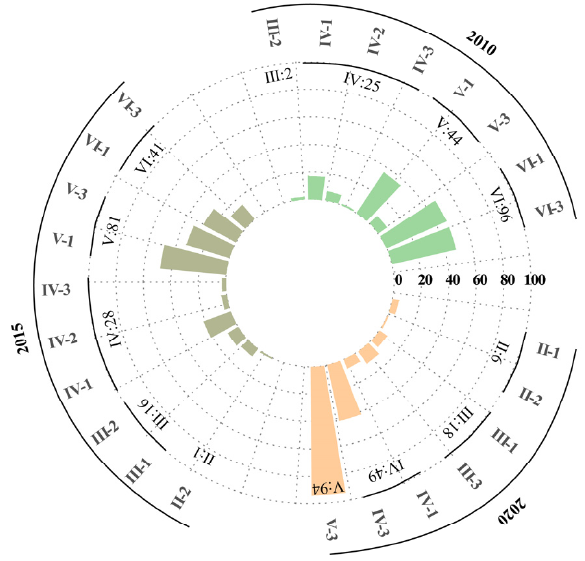
Figure 6. Coupling coordination degree type in 2010, 2015 and 2020.